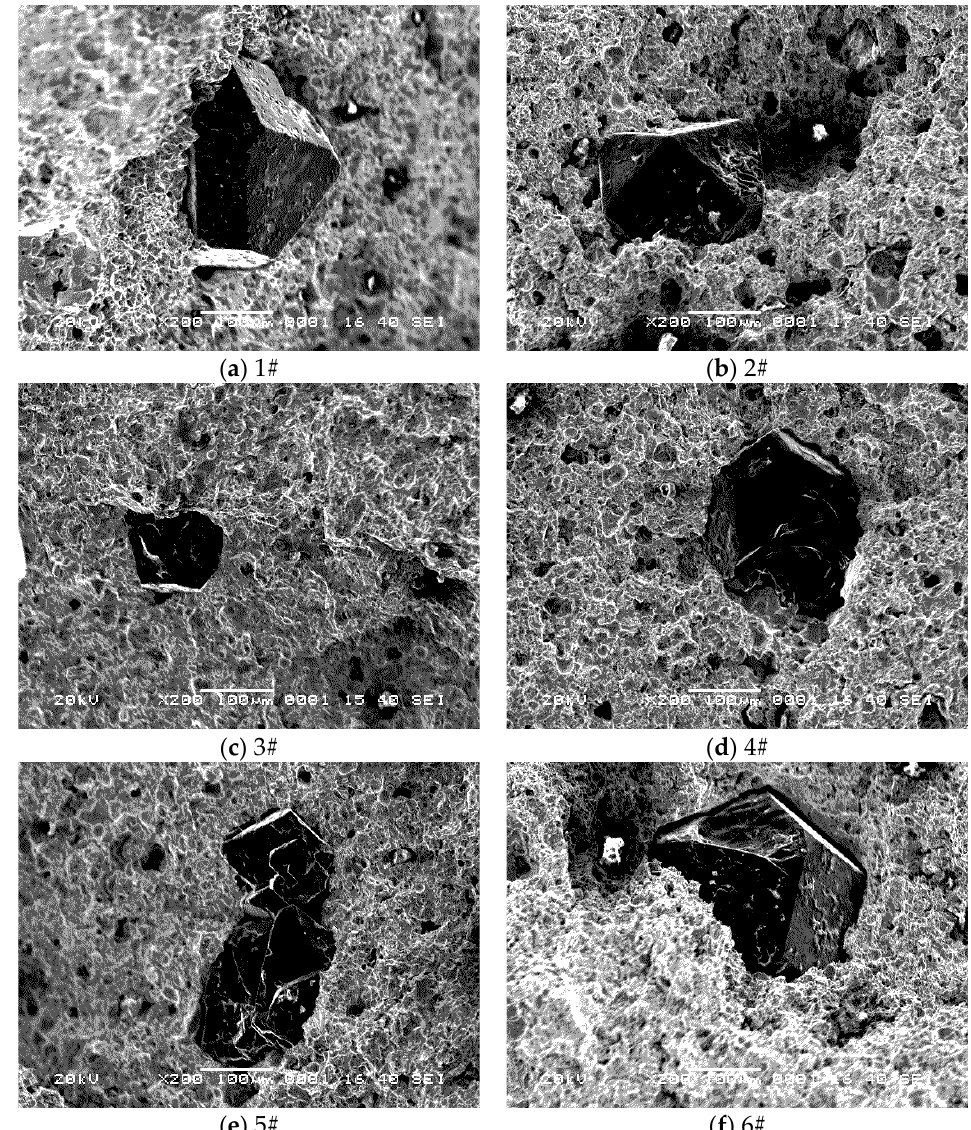
Figure 10. The bending fracture morphologies of diamond tools under pre-alloyed powders with different Sn contents.